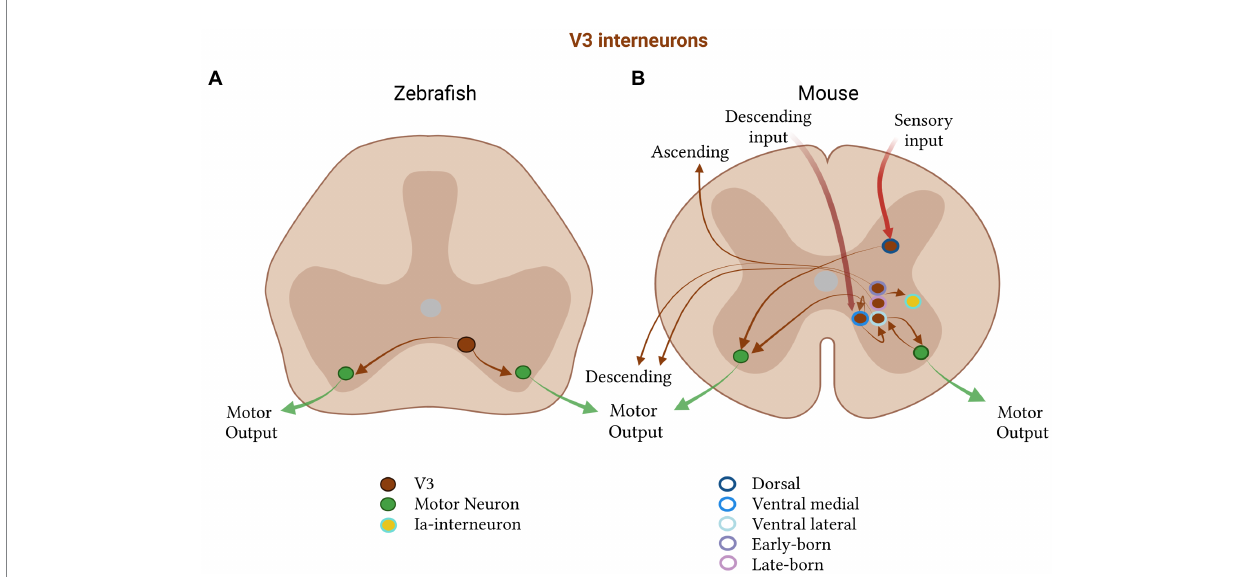
FIGURE 3 Excitatory V3 subtypes in zebrafish and mice. (A) In zebrafish, V3 neurons (brown) project to motor neurons (green) on both sides of the spinal cord and (B) in mice are divided into a dorsal (dark blue, outline) and ventral class, the latter of which is further subdivided into a medial (medium blue, outline) and lateral (light blue, outline) group. The ventral medial group receives descending commands, forms recurrent connections with itself, and projects to the ventral lateral group. The lateral group projects to motor neurons on the ipsi and contralateral side. Motor neurons project back to V3 neurons in mice. V3 neurons also subdivide by their birth time into an early-(dark purple, outline) and a late-born (light purple, outline) subpopulation, which form either both an descending and ascending, or only a descending, projection, respectively. V3 neurons in mice also project to Ia-